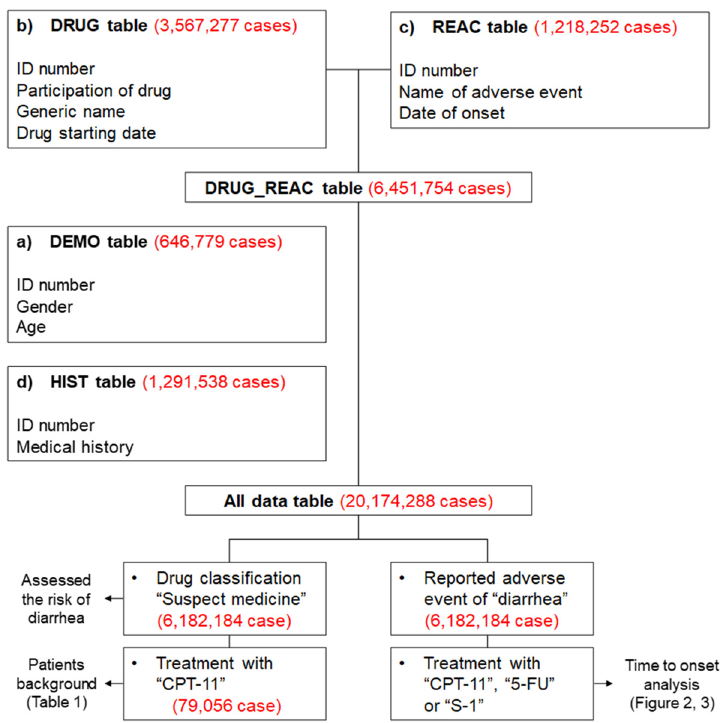
Figure 3. Four information tables included in the Japanese Adverse Drug Event Report (JADER) database. The red numbers show the number of reports obtained between April 2004 and Septem- ber 2020.